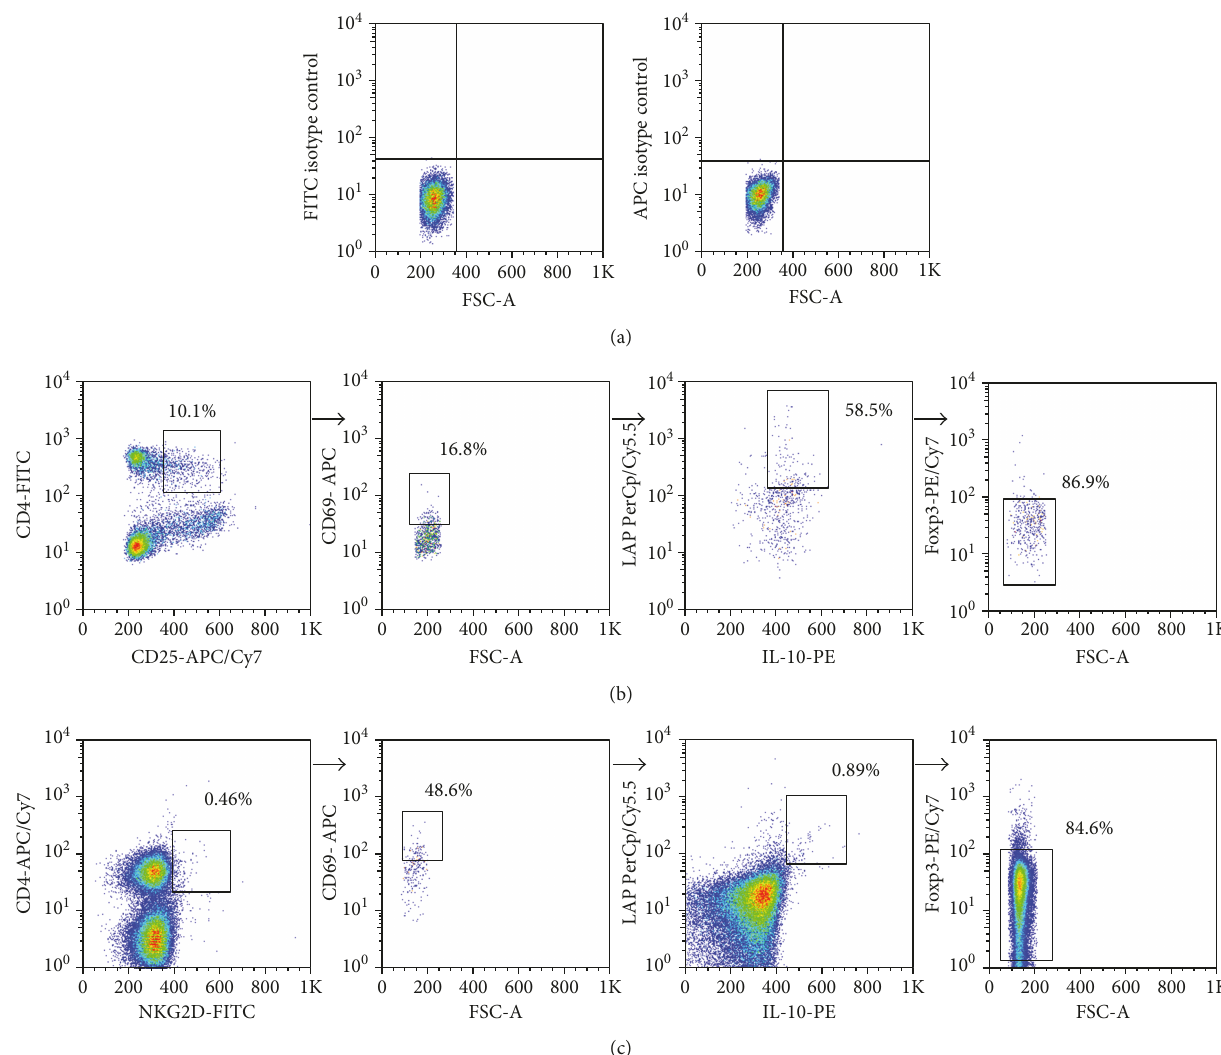
Figure 1: Flow cytometry strategy for the analysis of peripheral blood CD69 + Treg lymphocytes. Mononuclear cells were isolated from blood samples and labeled with mAbs against CD4, CD25, CD69, and LAP (TGF- β ). Then, cells were fi xed, permeabilized, and stained for IL-10 and Foxp3. (a) Dot plots of FITC and APC isotype antibody controls. (b) Strategy for the analysis of CD69 + Treg cells. Lymphocytes were gated on the basis of their size and complexity (not shown) and then analyzed for the expression of CD4 and CD25, CD69, LAP and IL-10, and fi nally for Foxp3. Results were expressed as the percent of CD4 + CD25 var CD69 + LAP + IL-10 + Foxp3 − cells, referred to mononuclear cells. (c) Strategy for the analysis of CD69 + NKG2D + Treg cells. Lymphocytes were gated on the basis of their size and complexity (not shown) and then analyzed for the expression of CD4 and NKG2D, CD69, LAP and IL-10, and fi nally for Foxp3. Results were expressed as the percent of CD4 + NKG2D + CD69 + LAP + IL-10 + Foxp3 − cells, referred to total lymphocytes. Numbers correspond to the percent of cells in the highlighted gate, referred to the total of events in the previous gate. Data correspond to a blood sample from a representative patient with SLE. In all cases, at least 1 × 10 6 events were analyzed, and gates were set up by using fl uorescence minus one